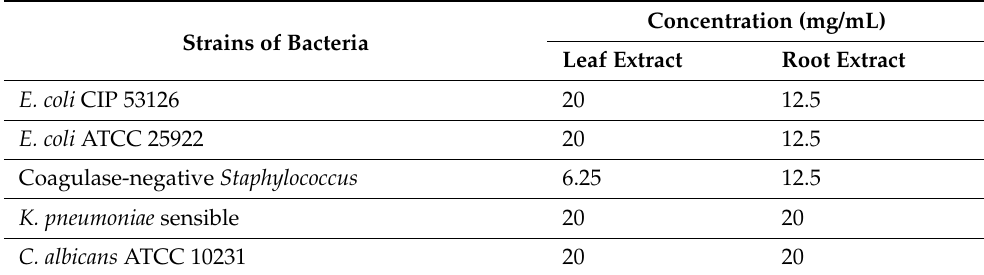
Table 5. C. humilis extracts and their minimum inhibitory concentration (MIC) values.